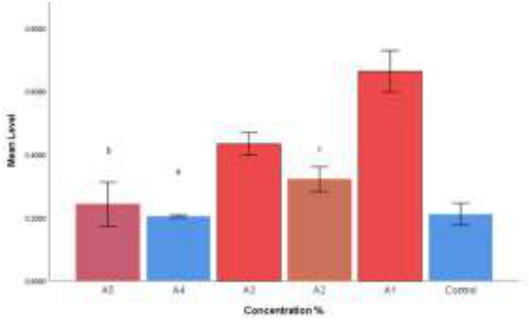
Figure 6. ANOVA diagram for different concentrations of fraction A. Fraction B (S\G\PE) Calculations of the percentage IR and mean comparison revealed that conc. 5mg/ml (B5) has